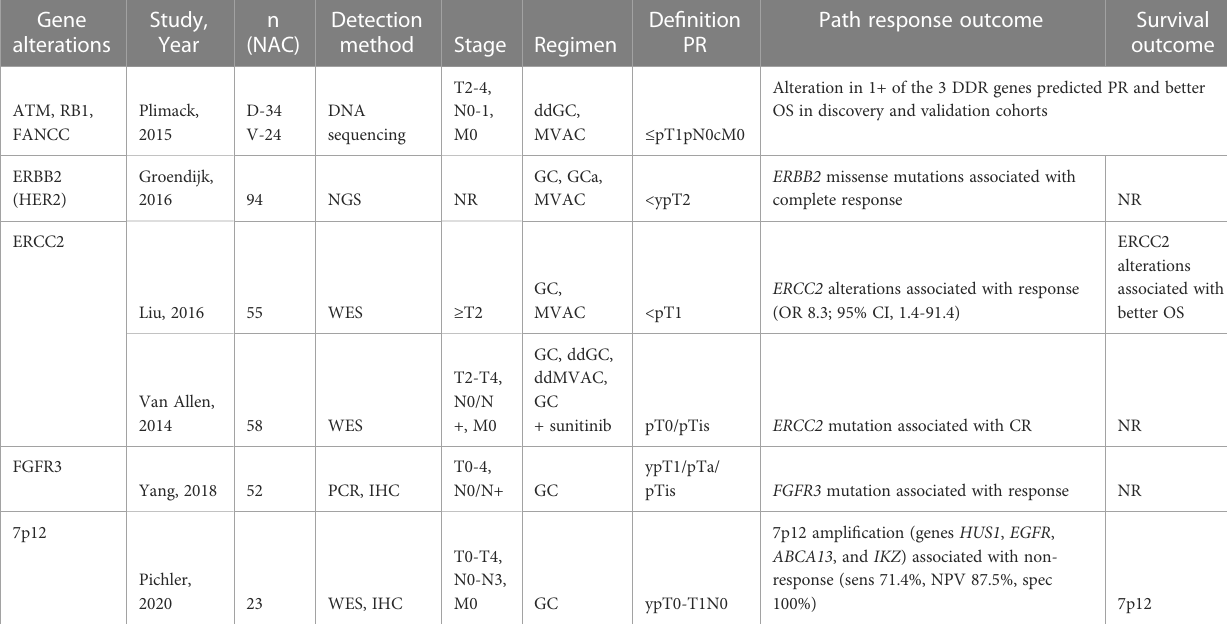
TABLE 4 Alterations in DNA damage repair genes associated with response to